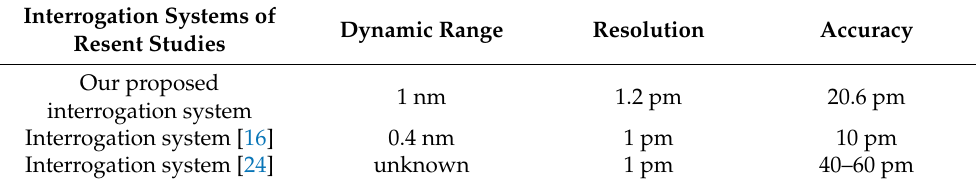
Table 3. Comparison of recent studies.